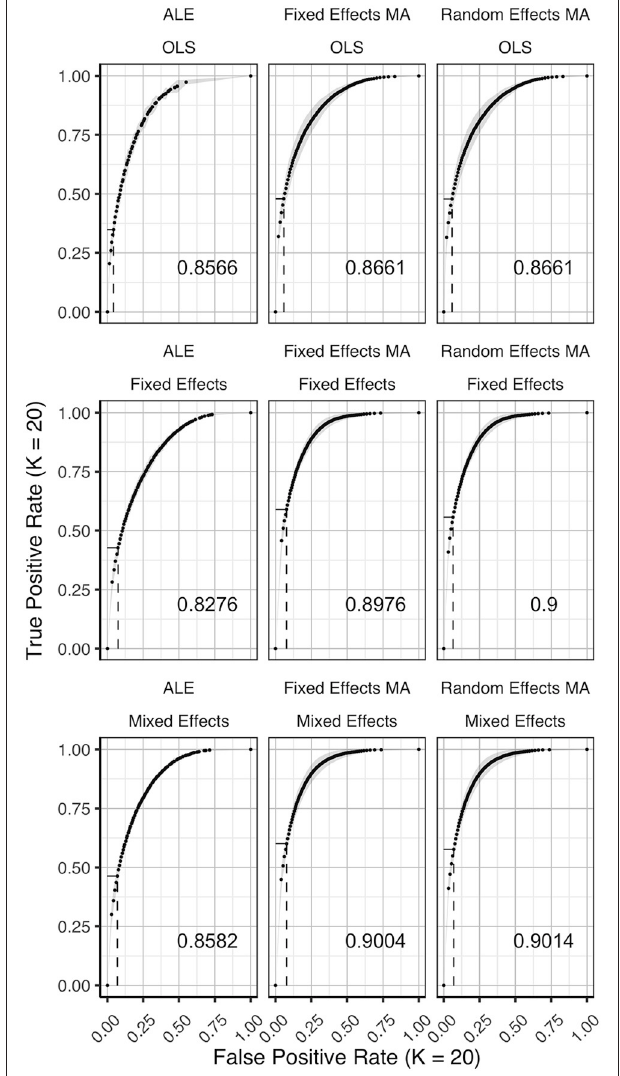
FIGURE 3 | ROC curves ( 1 standard deviation), averaged over I 7 folds ± = plotting the observed true positive rate against the observed false positive rate for K 10. The columns correspond to the coordinate-based meta-analyses = (left, ALE uncorrected procedure; middle, fixed effects meta-analysis; right, random effects meta-analysis). The rows correspond to the second level GLM pooling models ( top , OLS; middle , fixed effects; bottom , mixed effects). For each of those, the area under the curve (AUC) is calculated and shown within the plot. The drop-down lines correspond to the point at which the pre-specified nominal level is set at an uncorrected α level of 0.05.